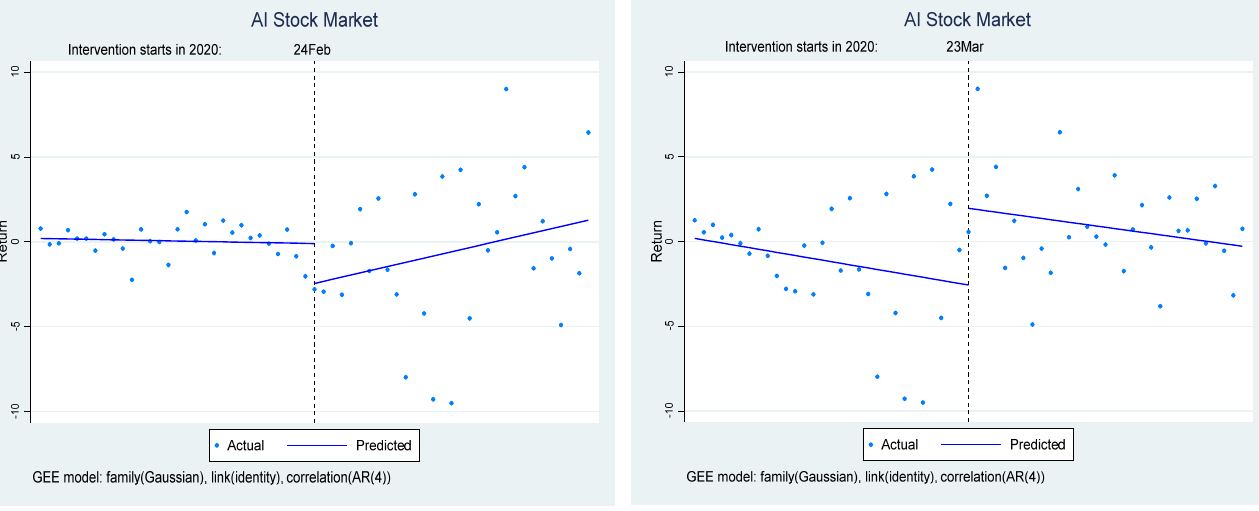
Figure 2. Single impact of COVID-19 on the artificial intelligence stock market. ( a ) The impact of the COVID-19 intervention t 1 (24 February 2020) is illustrated with the 3-month estimation period